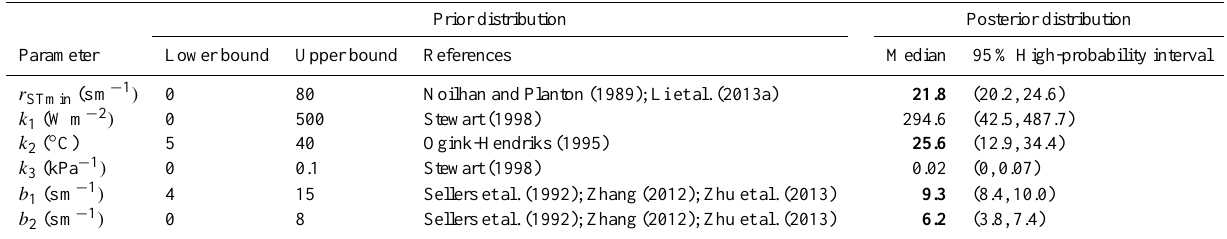
Table 1. Prior distributions and the parameter bounds for the S–W model. These values are derived from the literature; the posterior parameter distribution estimated by MCMC is based on observed data in our site, and are characterized by the mean and 95% high-probability intervals (lower limit, upper